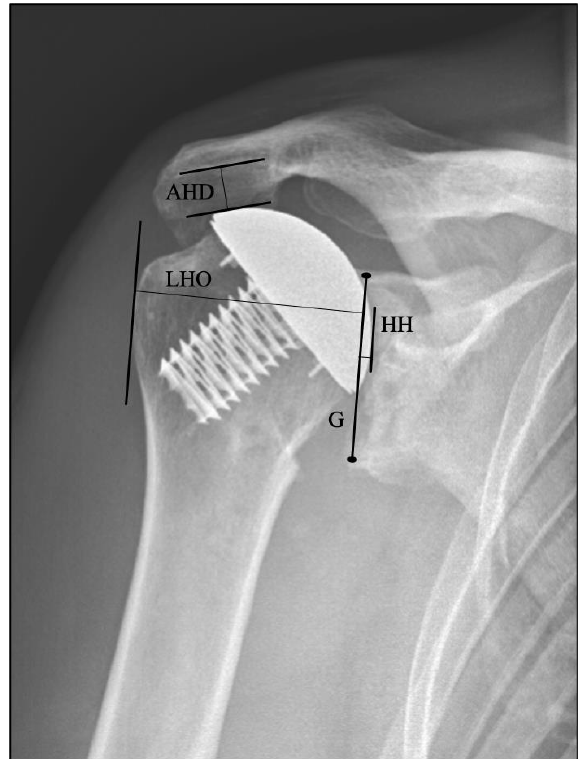
Figure 1. Anteroposterior measurements are illustrated on radiographs. The black line connects the superior and inferior rim of the glenoid (G) and is taken as the base for the joint gap width (black line to the right), which is the parallel line crossing the most medial part of the humeral head (HH) prosthesis. Positive values were given when the humeral head appeared more laterally relative to the drawn line, and negative values were given when more medially, respectively. The lateral humeral offset (LHO) is the distance (mm) measured from the drawn baseline to the parallel crossing the most lateral point of the greater tubercle. Acromiohumeral distance (AHD) is from the caudal point of the acromion perpendicular to the apex of the humeral head [28,29]. JG and LHO indicate a mediolateral shift of the humeral head, whereas the AHD represents